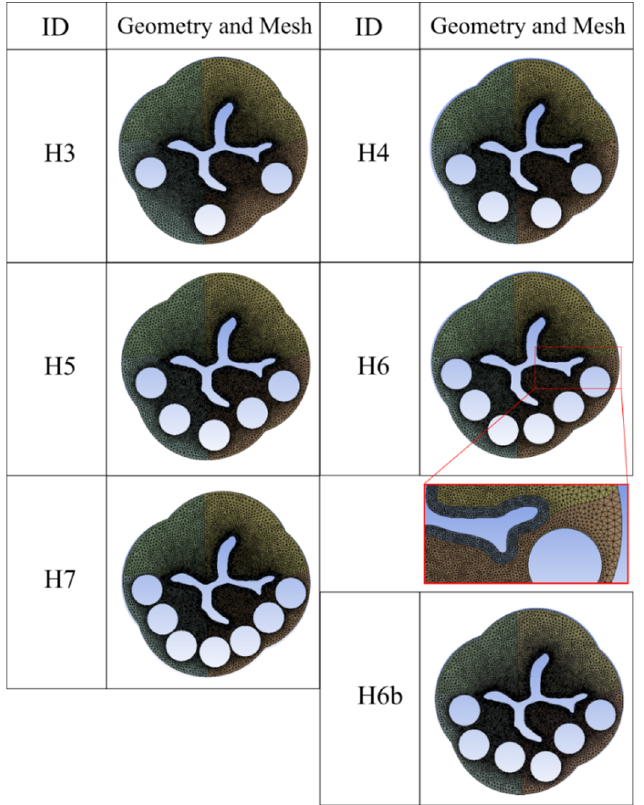
Figure 3. Meshed geometries of the domains for the numerical implementation, for all the studied perforated configurations.